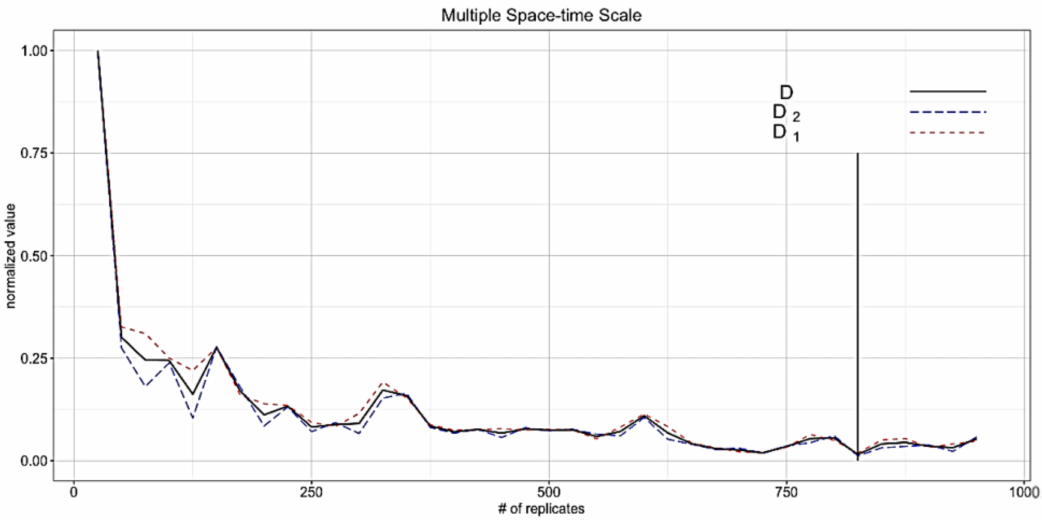
Figure 9. D , D 1 , and D 2 over the number of